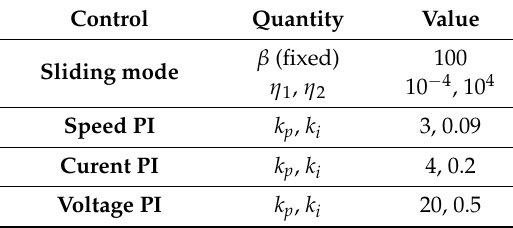
Table A1. Control gains.